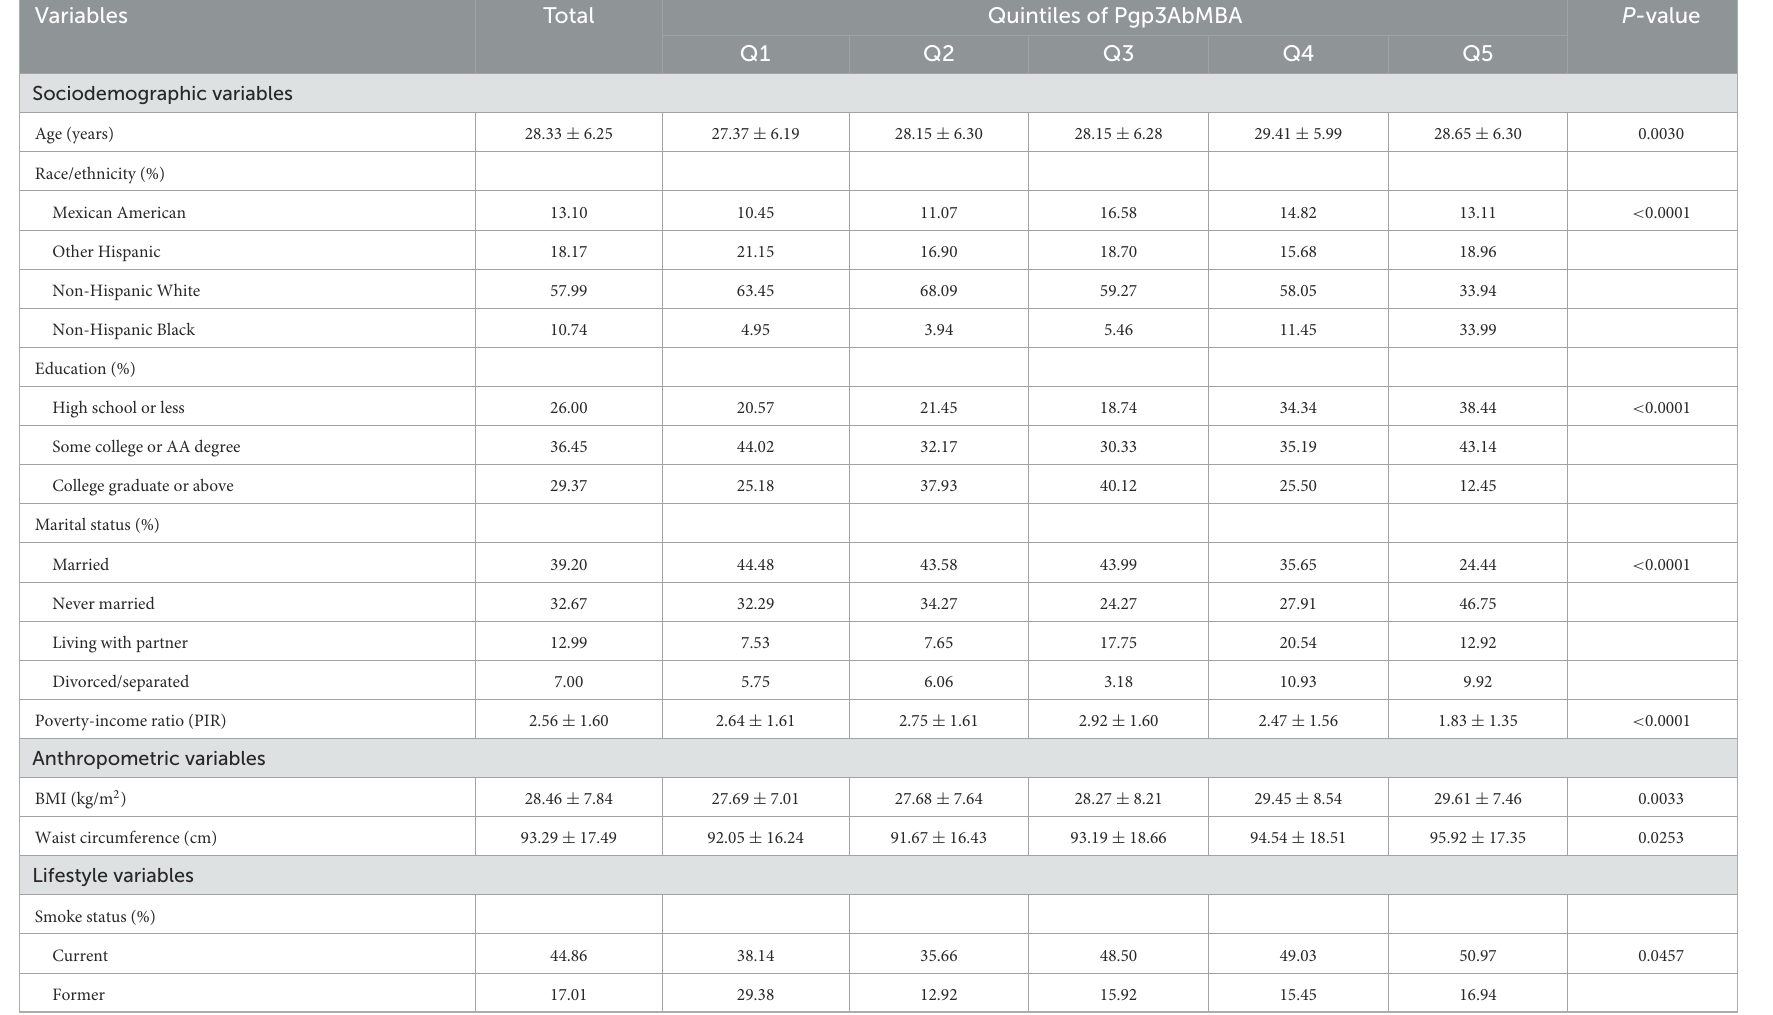
TABLE 1 Baseline characteristics of study participants by quintiles of Pgp3AbMBA. Variables Total Quintiles of Pgp3AbMBA P-